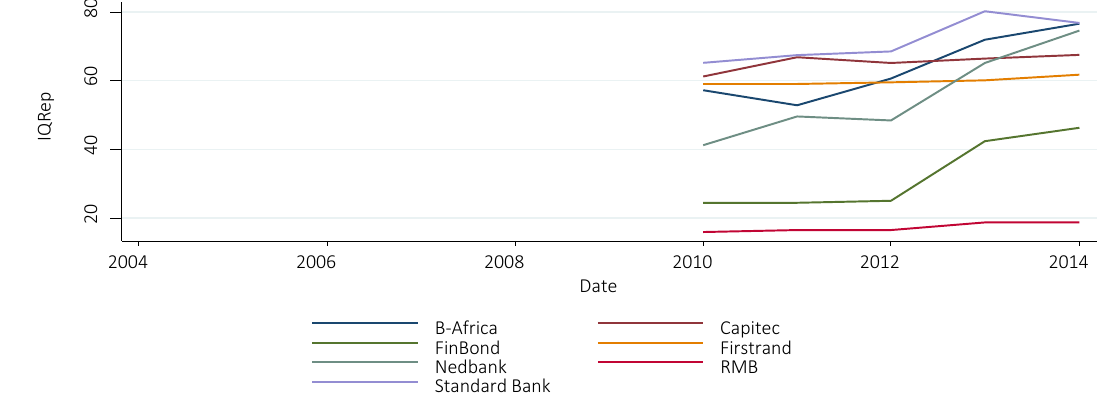
Figure 2. Line plots for integrated reporting quality of the banks over the period